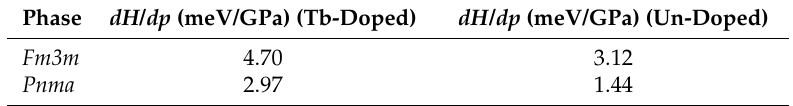
Table 1. Pressure dependence of the grain activation energy of Tb-doped and un-doped CaF 2 nanocrystals. phase dH/dp (meV/GPa) (Tb-doped) Fm3m 4.70 3.12 Pnma 2.97 1.44